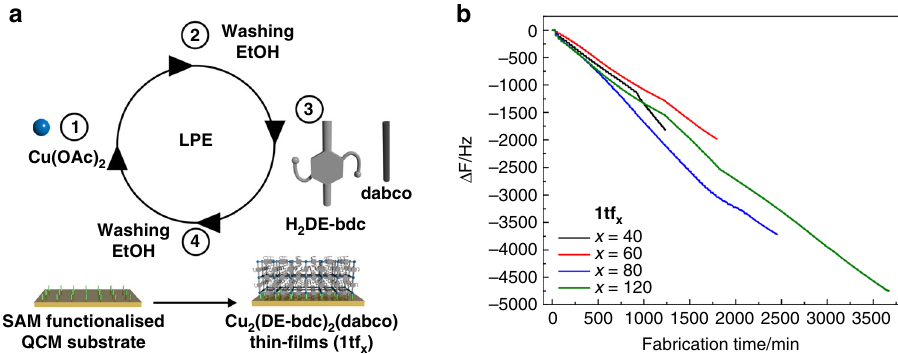
Fig. 3 LPE growth of 1tf x and changes in the QCM oscillator frequency ( F ) as a function of time during the growth. a 1tf x were fabricated via a stepwise LPE process in the continuous fl ow mode at 40 °C for 40 (black plot), 60 (red plot), 80 (blue plot) and 120 cycles (green plot). In each cycle, the QCM substrate was alternatingly exposed to the solutions of metal and mixed organic precursors followed by washing with ethanol after each precursor dosing step; b In-situ monitoring of the QCM frequency change indicates overall linear-growth pro fi les with respect to the number of repeated deposition cycles. Increasing the total number of deposition cycles shows a decrease of frequency. According to the Sauerbrey Equation, this observation indicates an increase of mass (i.e., MOF) anchored to the QCM substrate (corresponding to a thicker fi lm with larger